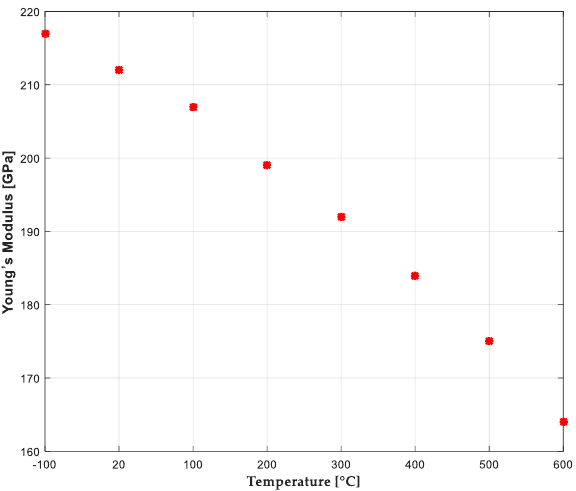
Figure 4. Dependence of elastic modulus on temperature [50].